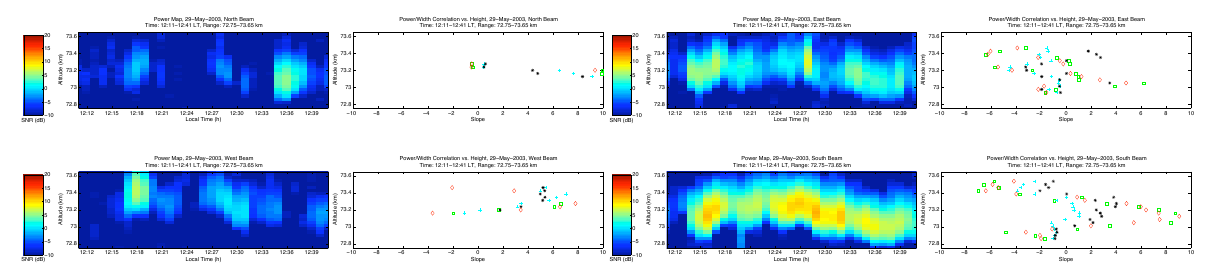
Fig. 22. SNR map and correlation plots of all four beams of event at 73.25km on 29 May 2003 at 12:11 LT.